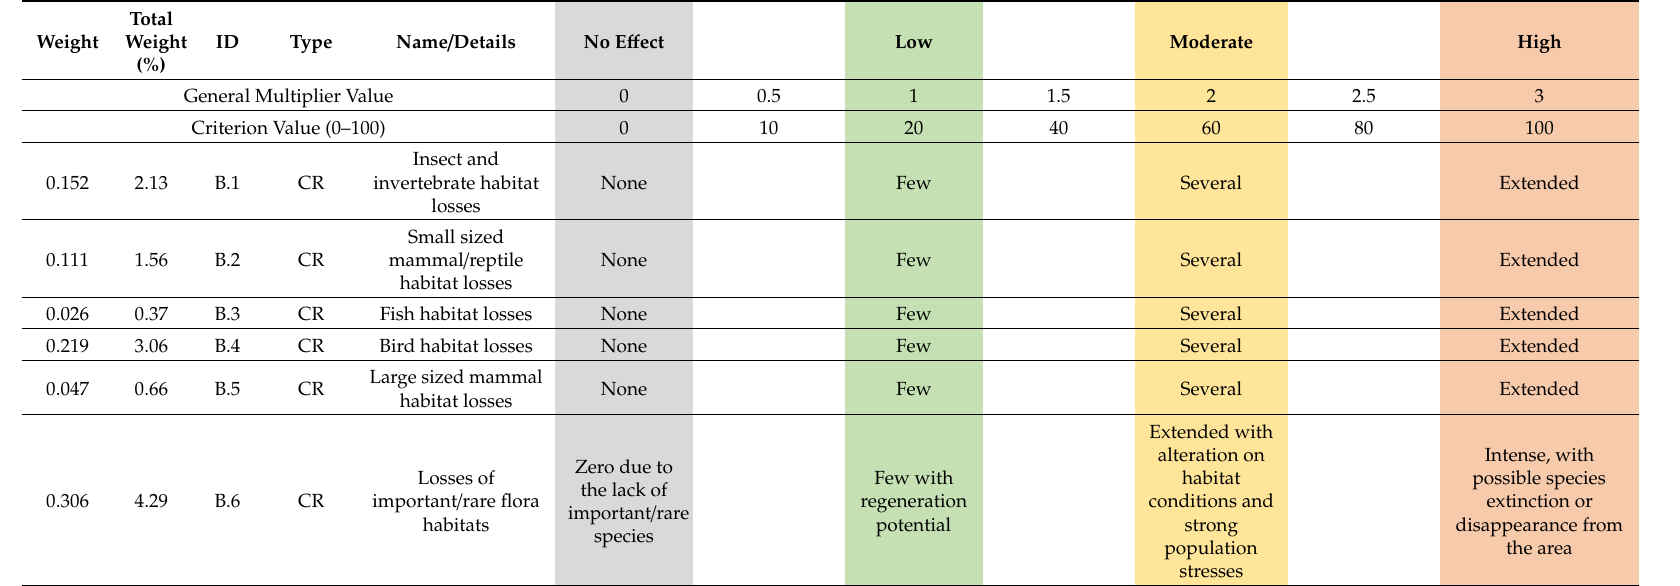
Table A2. Criteria, choices, and weights for the general environmental impacts fire e ff ects category. CR: criterion; AT: additive term; GM: general multiplier. Light gray: Choices with no e ff ect; Dark gray: N / a, denotes a non-applicable or not available selection; Green: Choices with low e ff ect; Yellow: Choices with moderate e ff ect; Red: Choices with high e ff